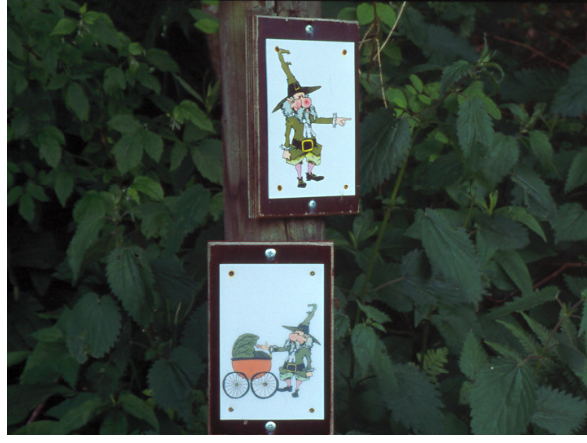
Figure 14. Two signposts for pedestrians and for baby carriages (Megerle 2001).